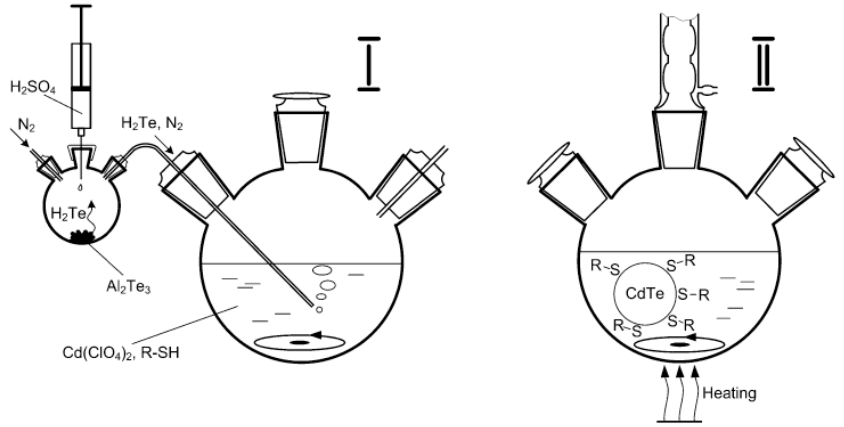
Figure 2. Schematic of CdTe synthesis using aqueous method [16]. Copyright 2002 American Chemical